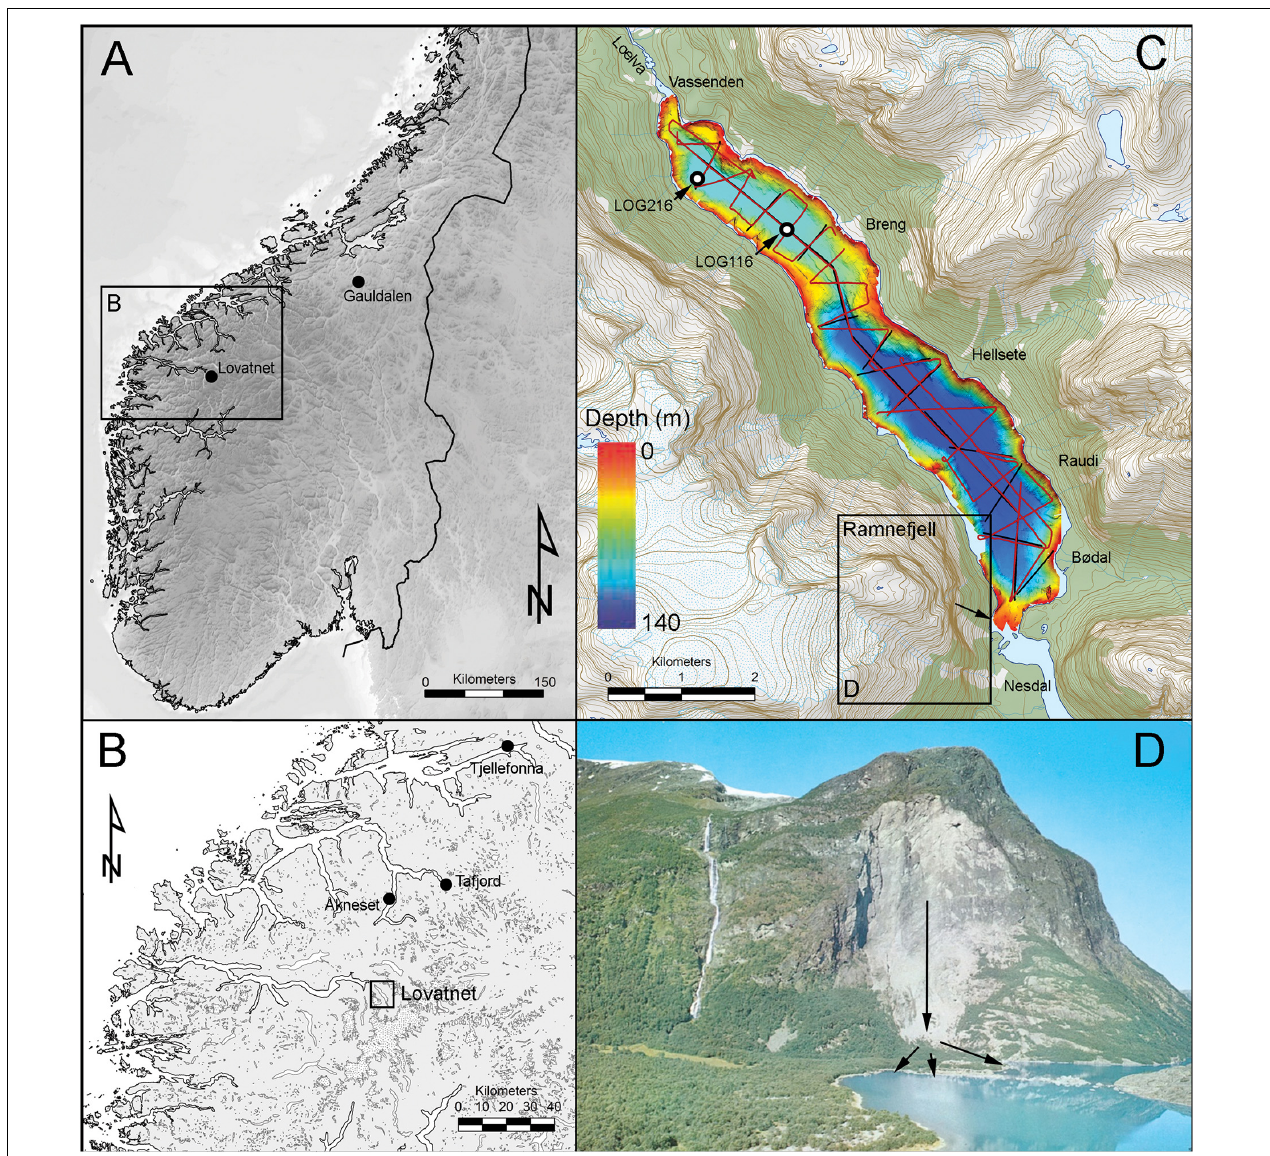
FIGURE 1 | (A) Map of southern Norway, the study area of inner Nordfjord and surrounding region is marked. (B) Location of Lake Lovatnet marked by a black square in inner Nordfjord. Sites with known records of rock fall events and associated tsunamis are marked by black dots (see text for more details). (C) Swath bathymetric map of Lovatnet showing pinger- (red) and airgun (black) seismic profiles. Sites of cores LOG216 and LOG116 are shown as a white circle in the NW sub-basin. The Ramnefjell slide scar is indicated with an arrow. Lake Lovatnet occupies the entire area of Lodalen Valley. (D) Picture of Ramnefjell with the location of the rock fall (Normann,